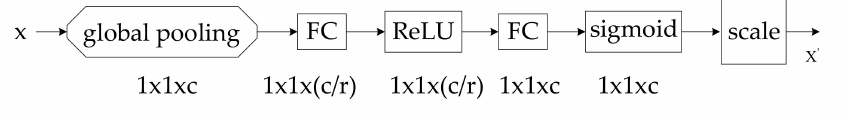
Figure 5. Structure of channel-attention